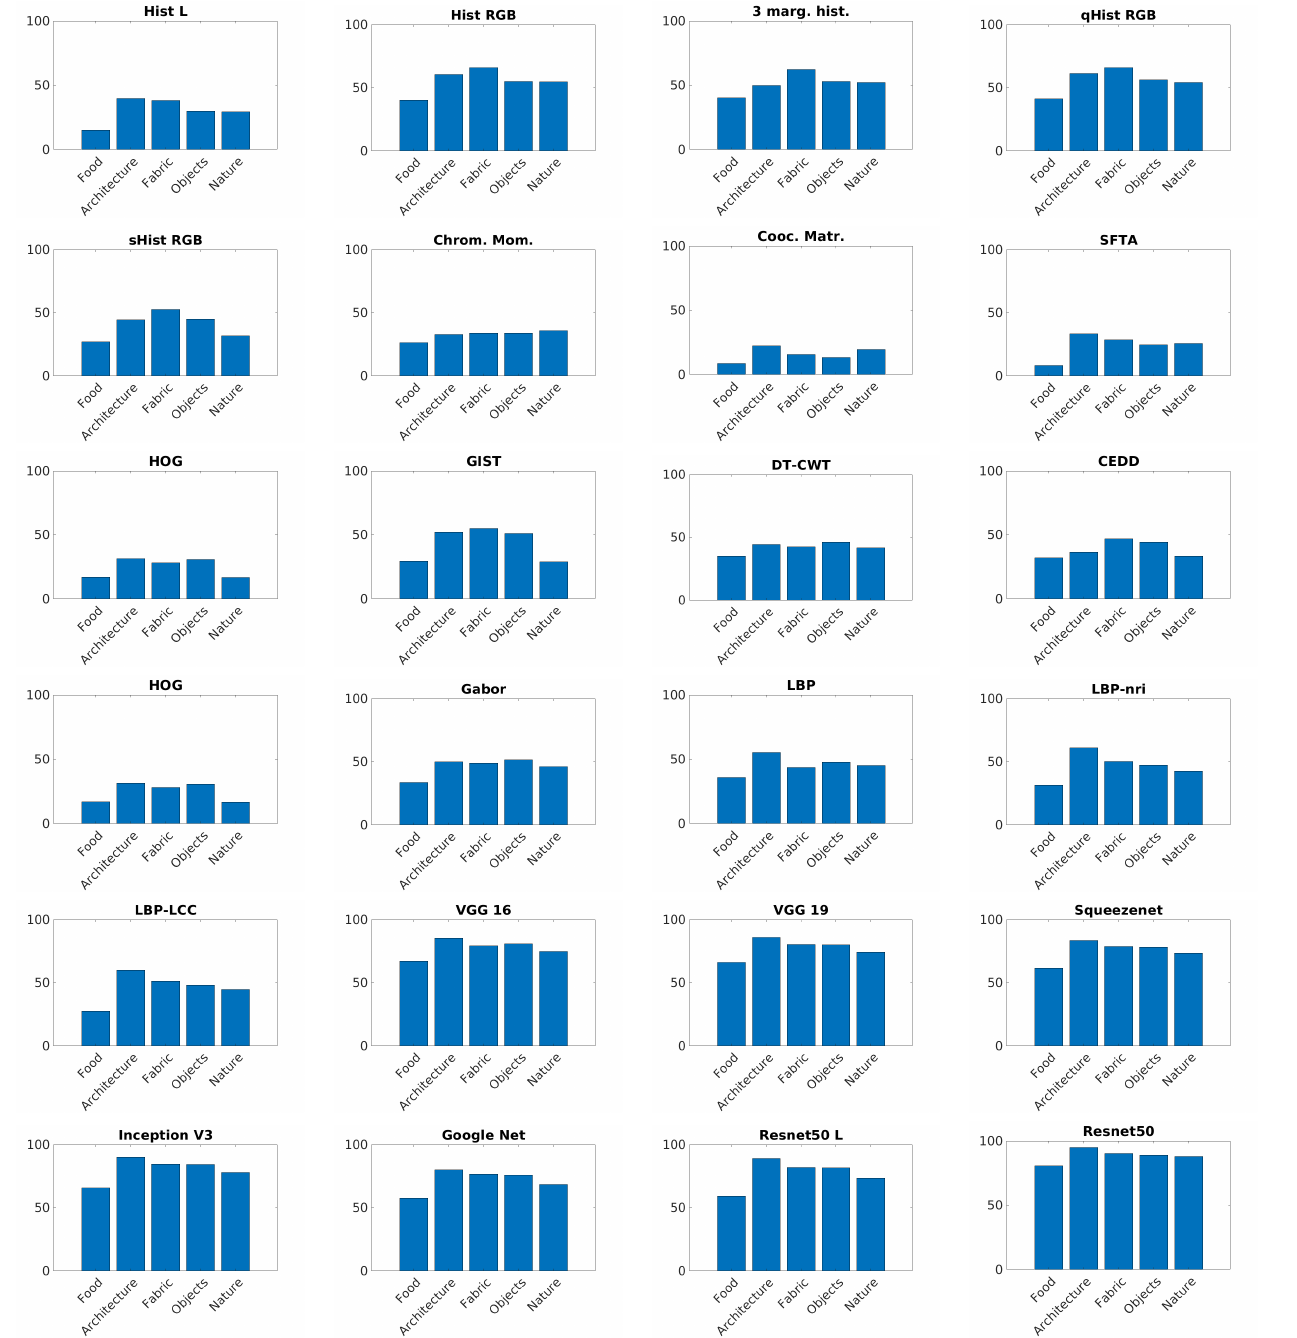
Figure 9. Performance of each visual descriptor on each thematic